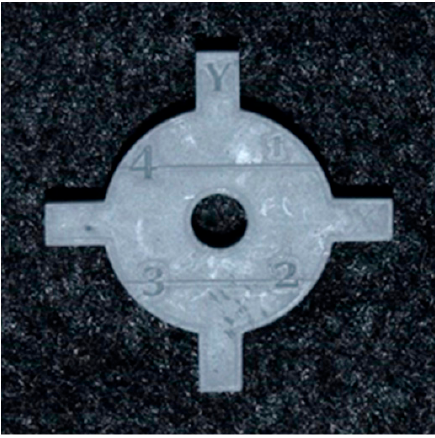
Figure 6. Final printed coupon in the resin for dental models (Grey V4 Resin, Formlabs, Somerville, MA, USA).